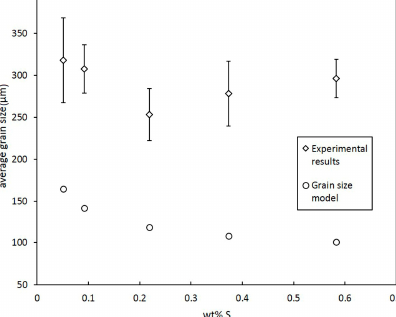
Figure 2. Grain size as a function of Mg ( a ), P ( b ) and S ( c ). Figure 2. Cont.